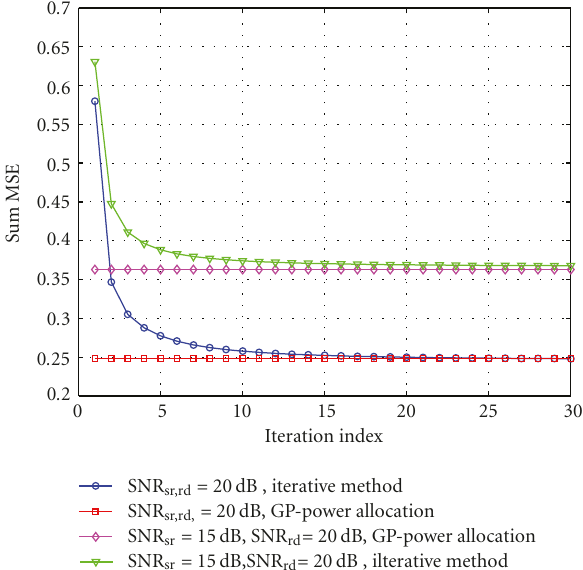
Figure 3: Convergence performance of the iterative approach and the GP power allocation method for the case without the direct link = σ 2 = 0 . 01, and P max = P max = 0dB). ( α = 0 . 3, β = 0, σ 2 e ,1 e ,2 S R